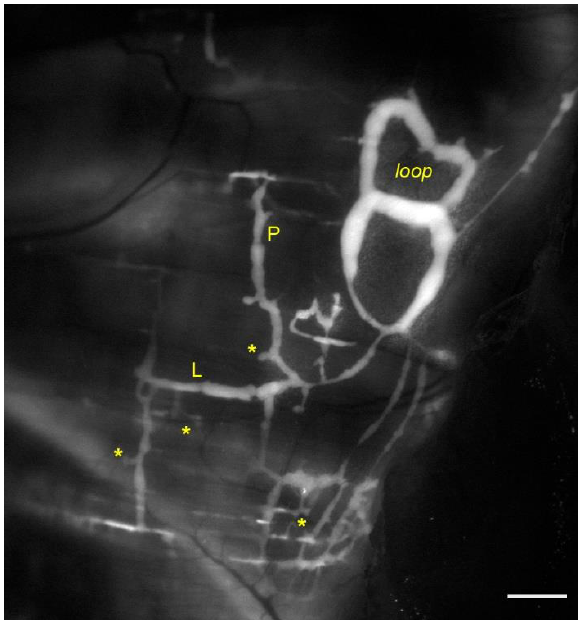
Figure 1. Representative image of lymphatic vessels organization on the pleural side of rat diaphragm, after the in vivo staining with a FITC-conjugated fluorescent tracer. Lymph enters lymphatic lacunae ( asterisks ) and then is propelled through vessels longitudinally ( L ) and/or perpendicularly ( P ) arranged with respect to the skeletal muscle fibers orientation. Lymphatic collectors located at the muscle periphery, next to the costal margin, are typically organized in complex loop structures (loop) and display intrinsic contractility. Scalebar 1